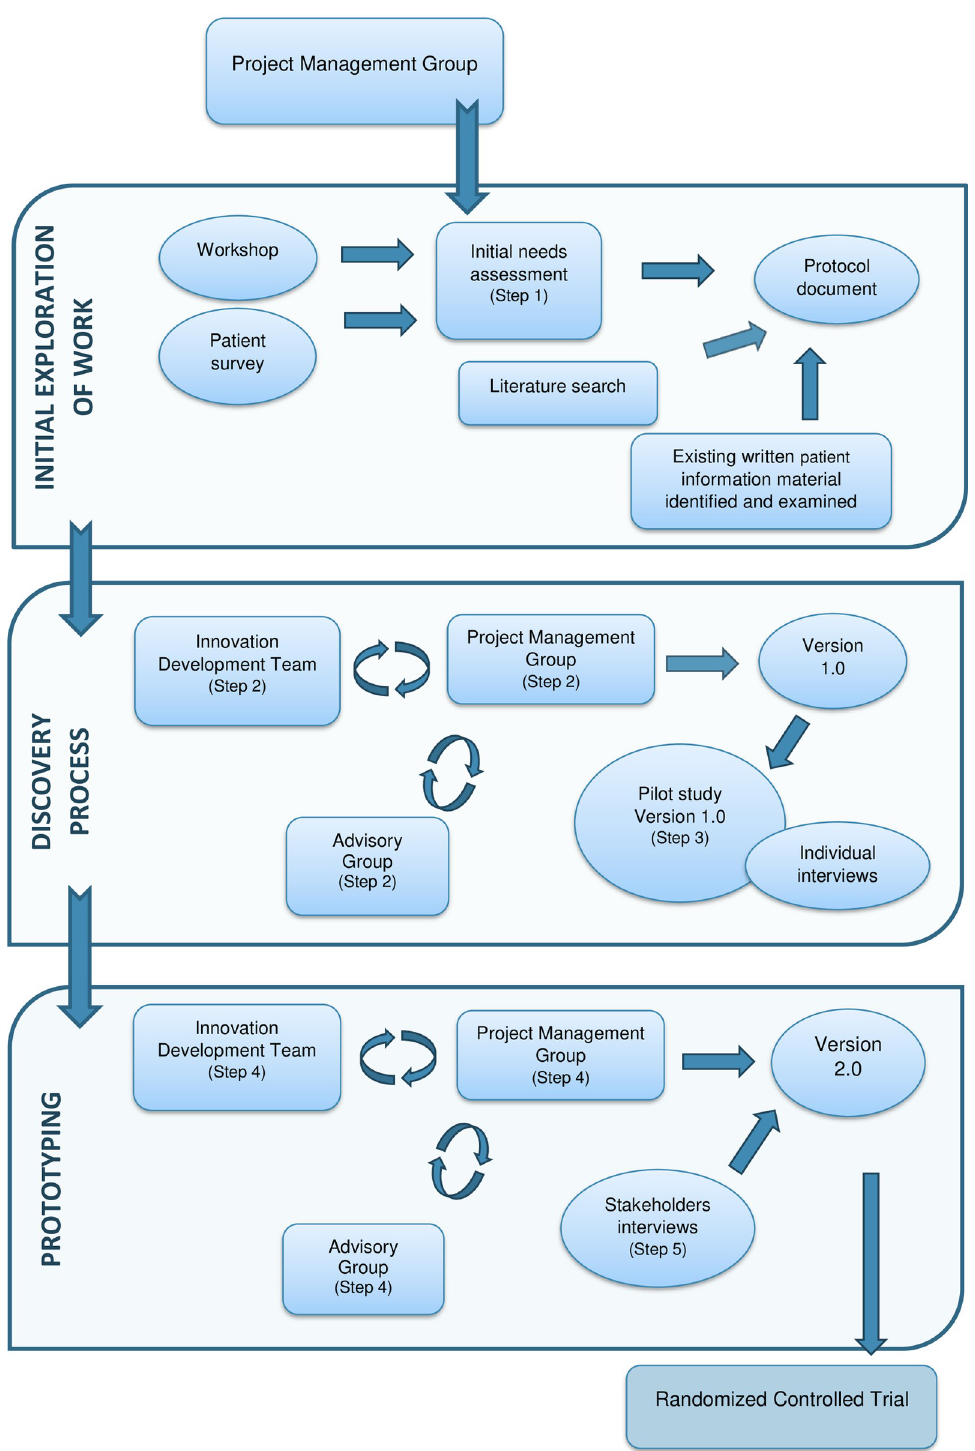
Fig 1. Complementary steps in the work process. The three stages relate to participatory design methodology combined with a variety of steps. The shaded areas illustrate steps of the development of the digital information tool (step 1–4) and reflection of the process (step